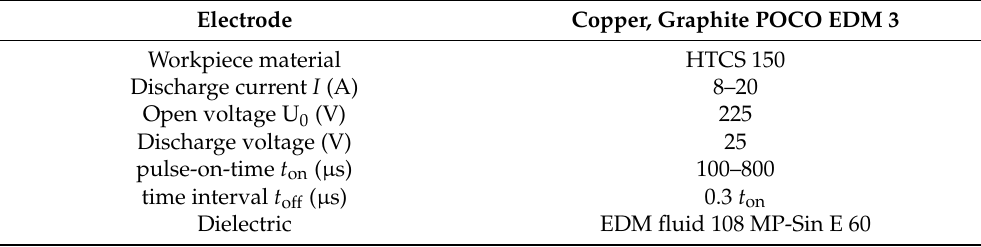
Table 3. Machining conditions.